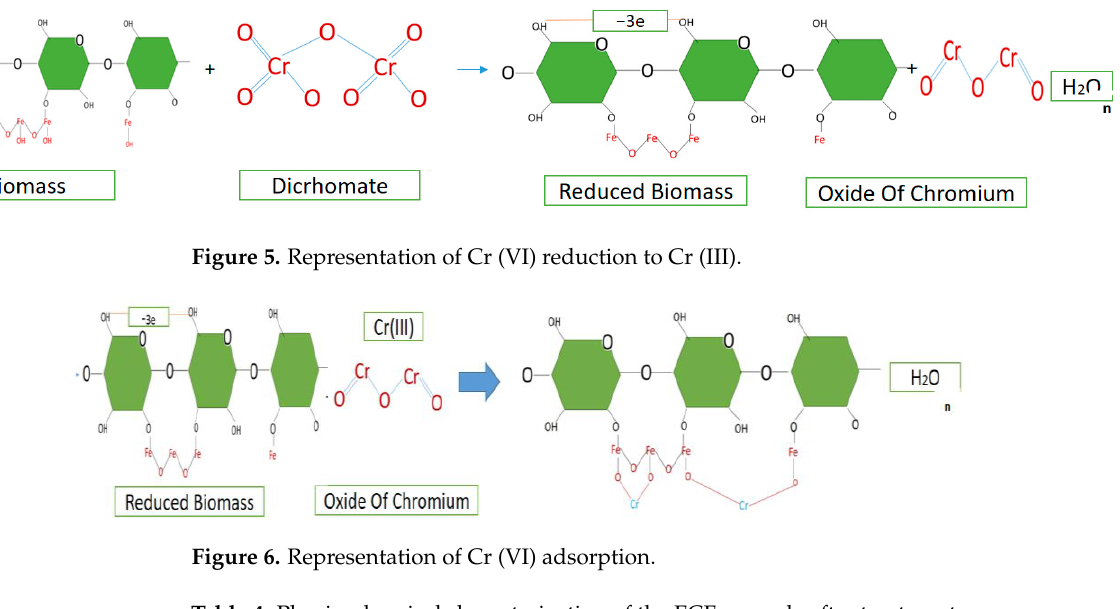
Figure 5. Representation of of Cr(VI) reduction to Cr (III).